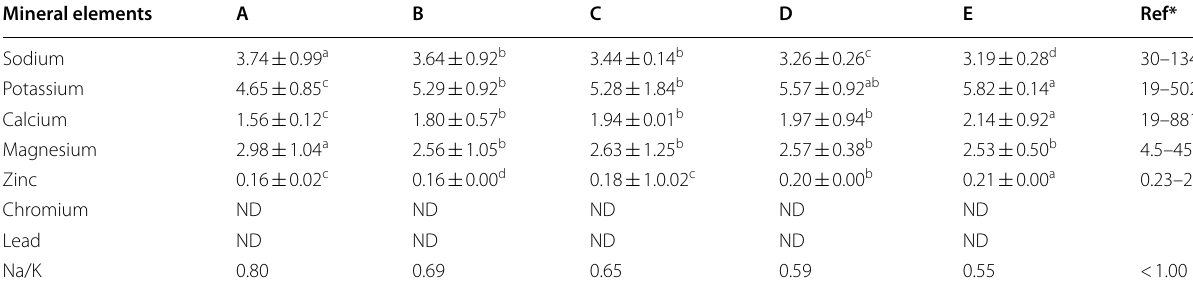
Mean standard deviation of three determinations. Values with different superscripts on a row are significantly different at p < 0.05 ± CSF: corn silk flour; LF: lemon flour; A: 100% CSF; B: 95% CSF and 5% LF; C: 90% CSF and 10% LF; D: 85% CSF and 15% LF; E: 80% CSF and 20% LF. ND: not detected, Ref* FAO (2010) and USDA (2010) limits (mg/day)